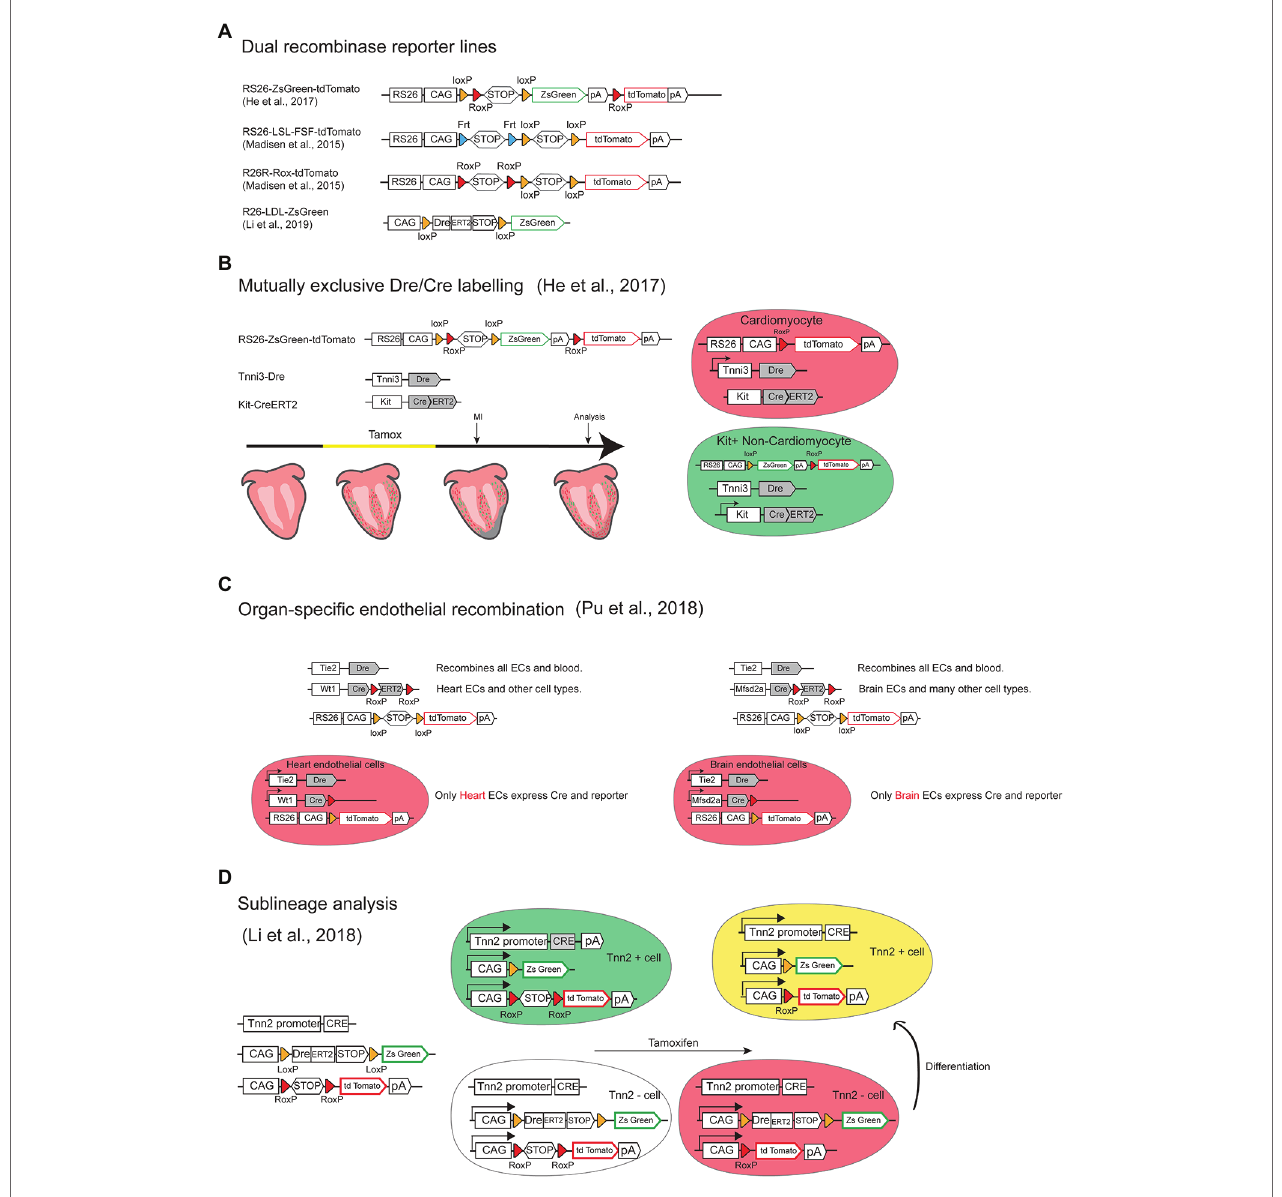
FIGURE 4 | Intersection genetics by combining Cre and Dre mouse lines. (A) Schemes of the alleles of dual (Cre/Dre or Cre/Flp) reporter lines available for intersection genetics. (B) Scheme of the alleles and strategy used to achieve mutually exclusive Cre and Dre recombination and labeling of cardiomyocyte (Tnni3+/ tomato+) and non-cardiomyocyteckit+ cells (Tnni3-/ZsGreen+) to enhance precision of lineage tracing after administration of tamoxifen and myocardial infarction (MI). (C) Scheme of the alleles and strategy used to achieve organ-specific (heart or brain) endothelial recombination. (D) Scheme of the alleles and strategy used to perform sublineage and fate-mapping analysis of Tnn2+ and Tnn2- cells differentiation to